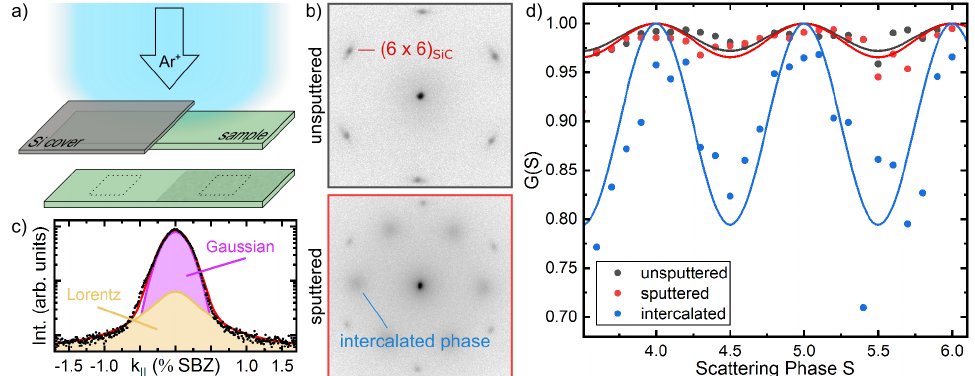
Figure 2. ( a ) Schematic showing the defect generation by Ar-sputtering on one half of the BL/SiC(0001) system. ( b ) SPALEED images of the vicinity of the (00)-diffraction spot after the Pb intercalation procedure (5 ML adsorbed followed by annealing) performed simultaneously on the non-sputtered (top) and sputtered (bottom) part of the sample. ( E = 100 eV). ( c ) Decomposition of the (00)-spot into a central peak (Gaussian) and shoulder (Lorentzian) ( E = 114 eV, S = 4.4). ( d ) G(S) analysis of the clean and sputtered surface (black, red) and Pb intercalation (blue). The measurements were performed at T = 300